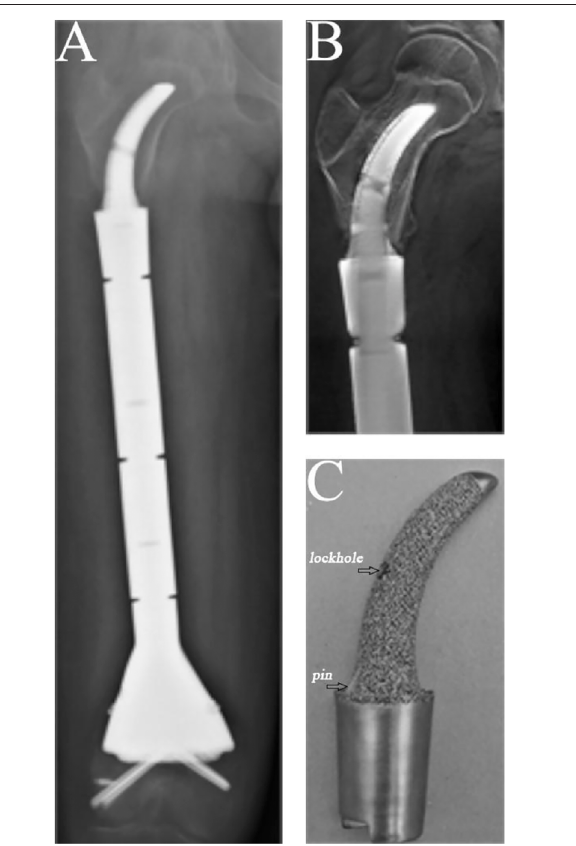
FIGURE 4 | A case of reconstruction of the femoral diaphysis following femoral diaphyseal resection of 73% of the length of the femur. (A) Posteroanterior radiograph of the entire femur. (B) Posteroanterior T-smart view of the stem insertion region of the femur. (C) Gross appearance of the curved